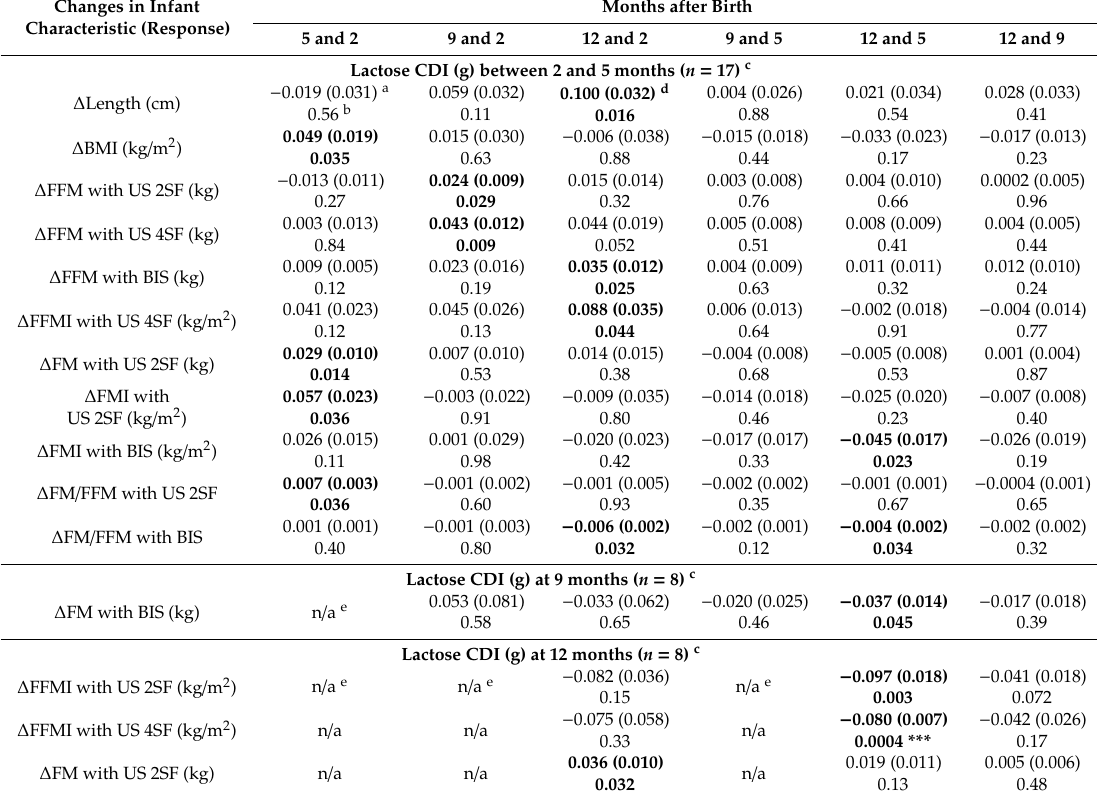
Table 5. Associations of calculated daily intakes of lactose at the time points with changes in infant body composition between the time